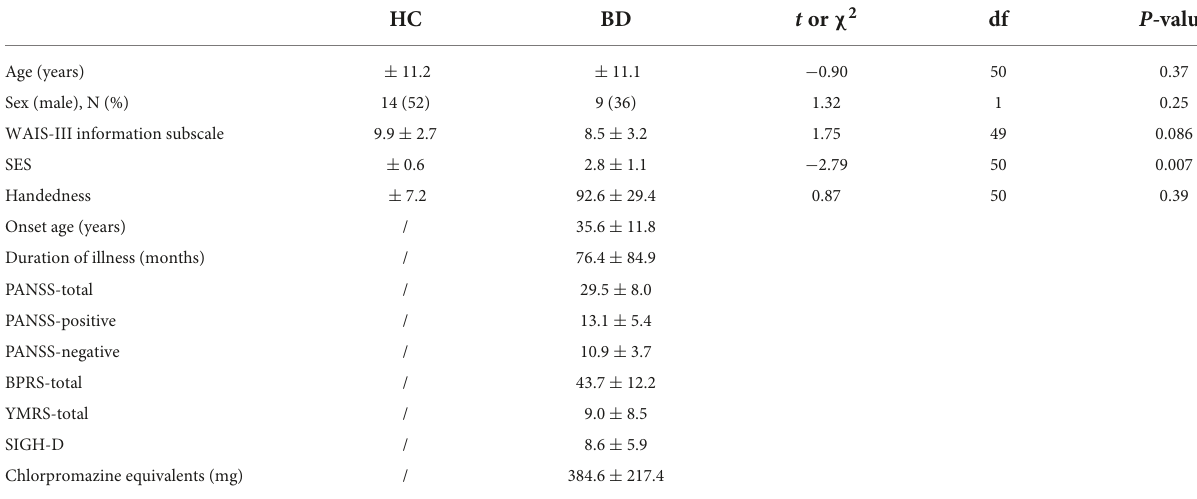
TABLE 1 Demographic and clinical characteristics of the study